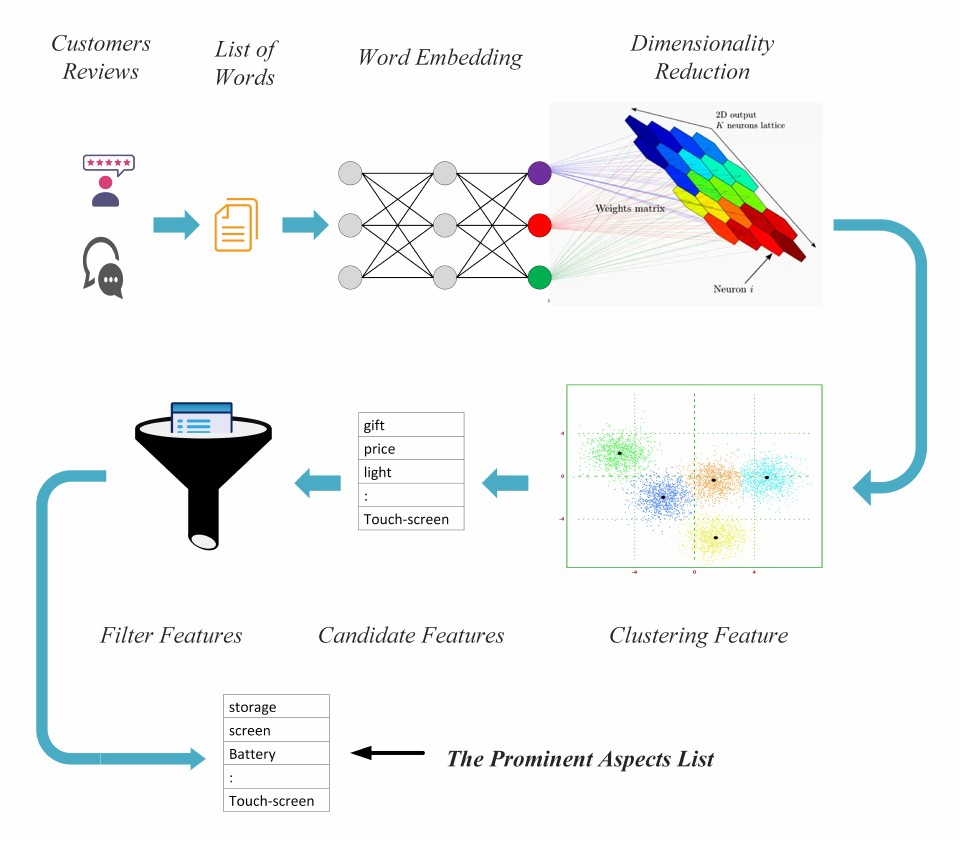
Figure 2. The experimental framework of the proposed aspect term extraction